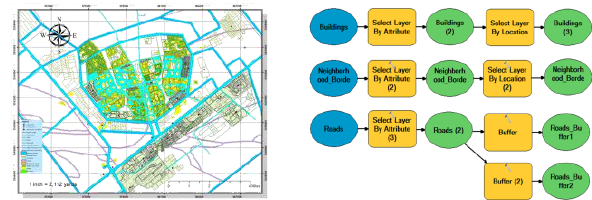
Figure 8. Mobility around the city other than transportation (walkability),